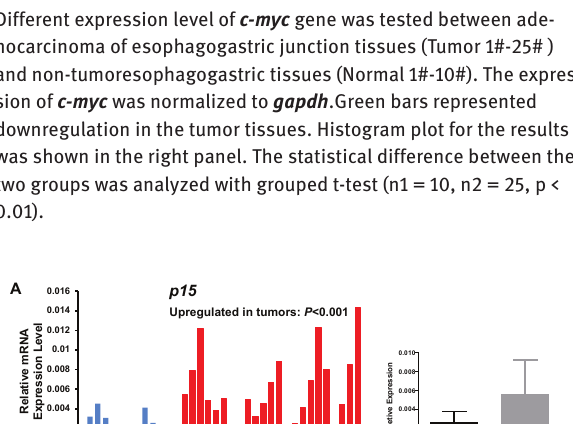
Different expression levels of Snail (A), ZEB1 (B)and Twist1 (C) genes between adenocarcinoma of esophagogastric junction tissues (Tumor 1#-25# ) and non-tumor esophagogastric tissues (Normal 1#-10#) were tested by qRT-PCR. The expression of Snail, ZEB1 and Twist1 was normalized to gapdh. Red bars represented upregula- tion in the tumor tissues. Histogram plot for the results in the right panels. The statistical differences between samples were analyzed with grouped t-test (n1 = 10, n2 =